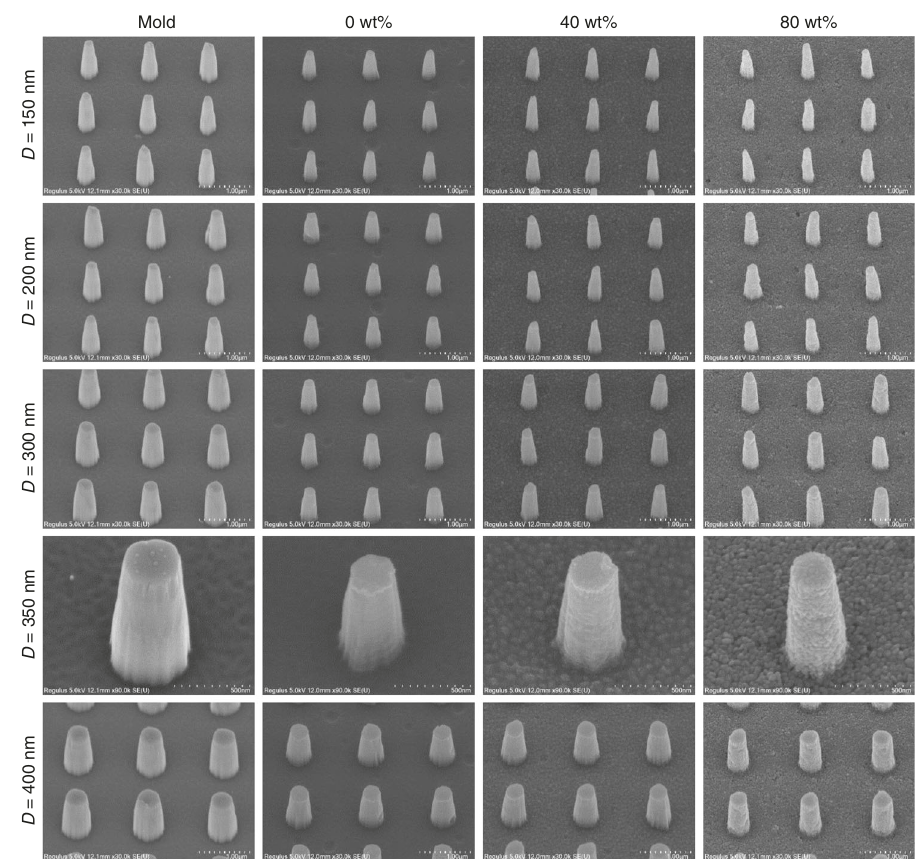
Fig. 4 Comparison of fabrication quality for circular nanopillar arrays. The titanium dioxide weight ratio varies from 0 to 80% while the diameter D of circular nanopillars changes from 150 to 400 nm. The height of nanopillars of the master mold is 1.2 µ m, and all the patterns are tilted by 30°. It is worth noting that the electron beam of a scanning electron microscope deforms the nanoparticle composite patterns, i.e., bending and height